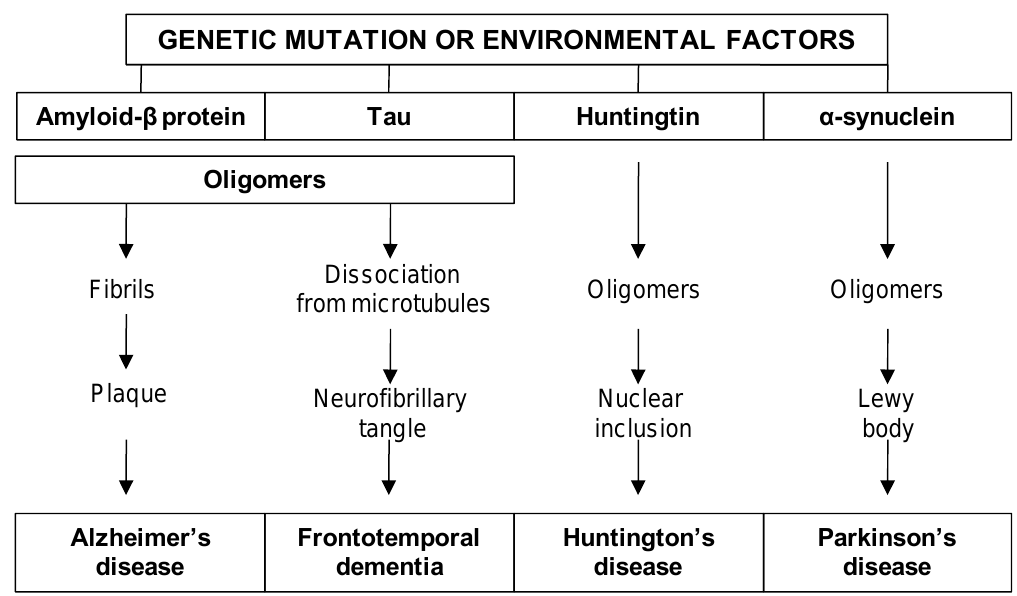
Figure 1. Schematic diagram outlining the pathogenesis of common neurodegenerative diseases (Adapted from Yuan and Yanker,